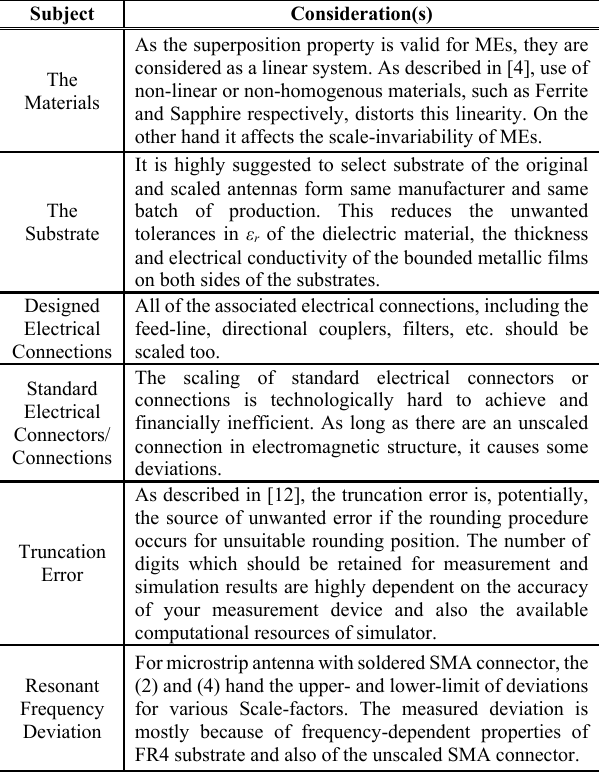
Table 2. The required consideration in scaling